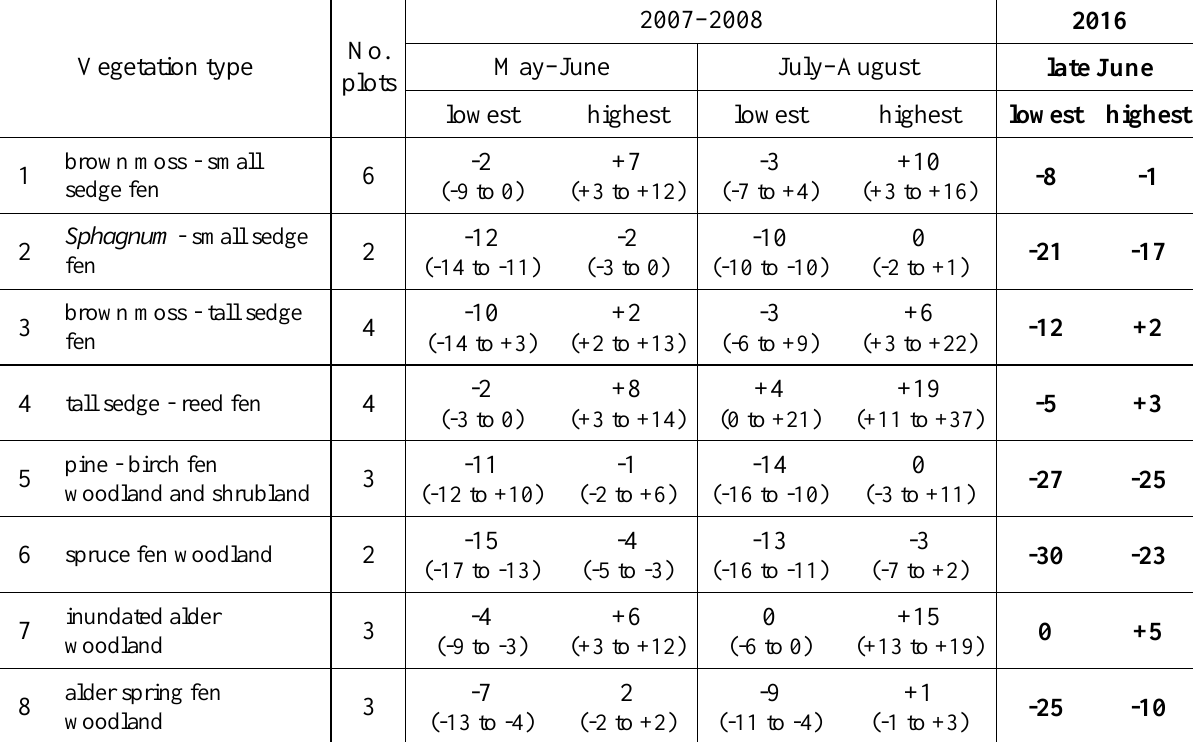
Table 1. Minimum and maximum water table levels (relative to ground surface level; units: cm) measured in dipwells located in selected ‘permanent’ sampling plots located along the five transects on the Rospuda mire, grouped according to the eight vegetation types distinguished here (2–6 plots per vegetation type). Water table levels were measured at 15-day intervals for two years (January 2007 to December 2008) and once at the end of June 2016. For each set of plots, median values and ranges of the lowest and highest water table levels (of ten) recorded per plot in May–June and in July–August 2007–2008 are shown, along with the lowest and highest water table levels recorded in